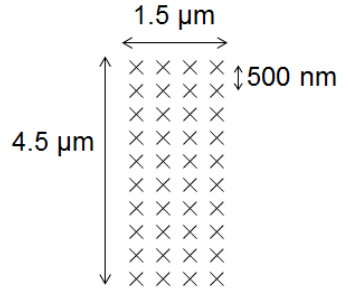
Figure 3. Contact positions on the aluminum oxide substrate.